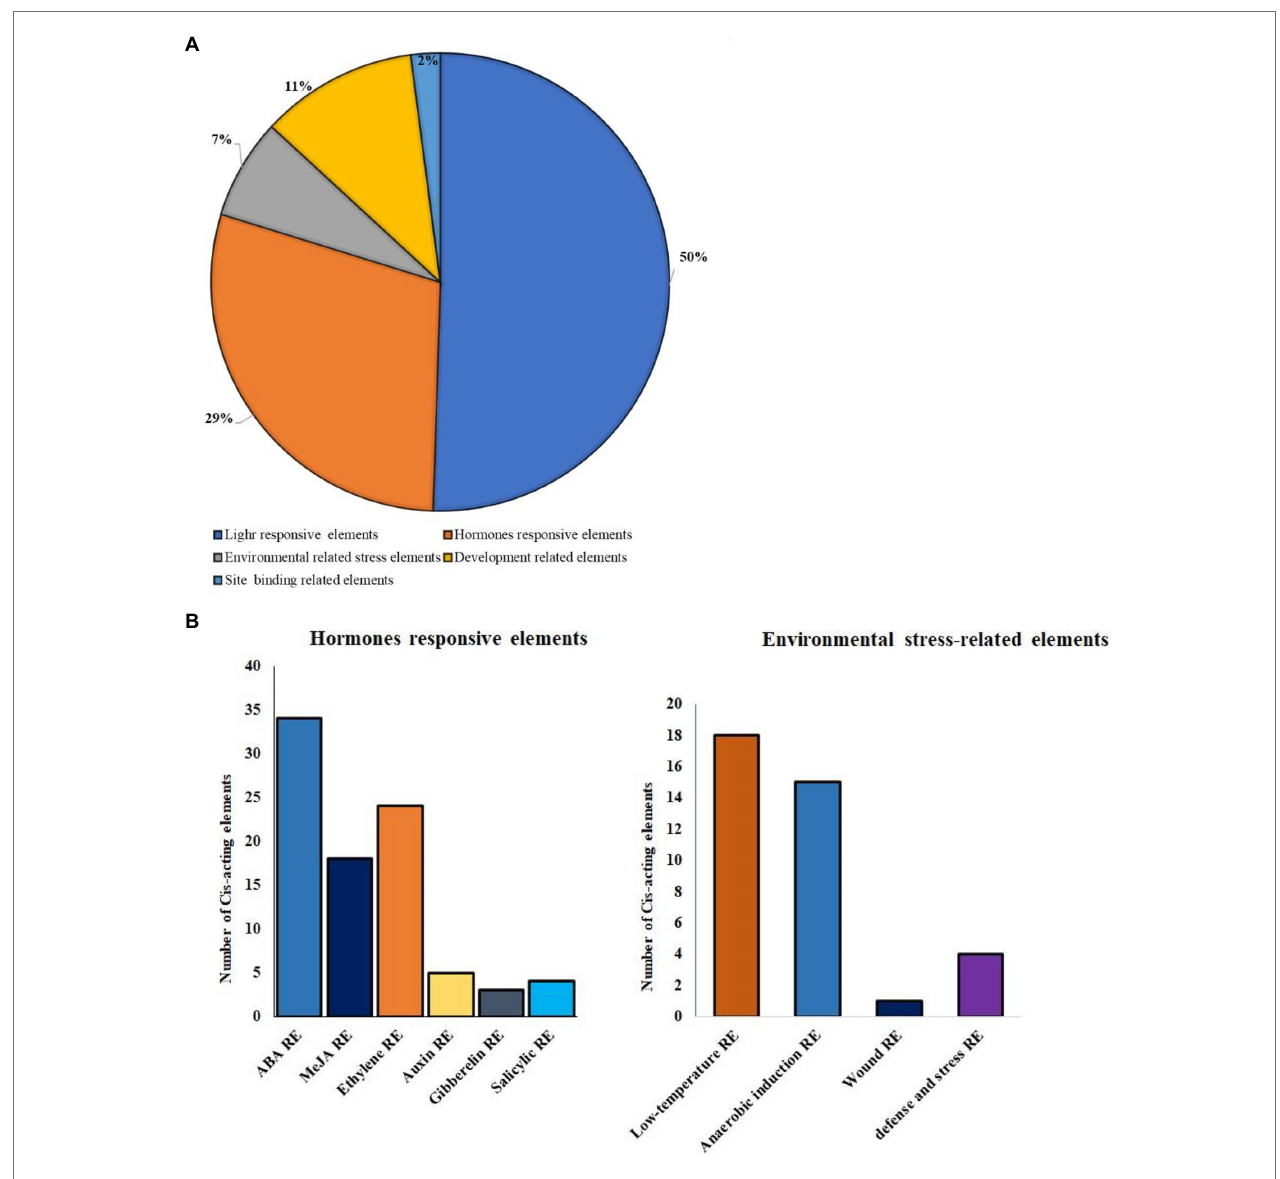
FIGURE 5 | Distribution of cis-elements in the promoter of B. oleracea Hsp90 genes. (A) The proportion of cis-elements in the promoters of B. oleracea Hsp90 genes are are shown in a pie chart. (B) Different hormones responsive elements and environmental stress-related elements in 12 BoHsp90 genes cis-elements